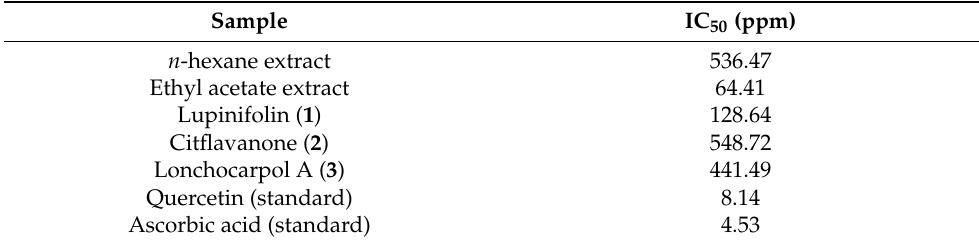
Table 4. Antioxidant activities of extracts and 1–3 of E. crista-galli.